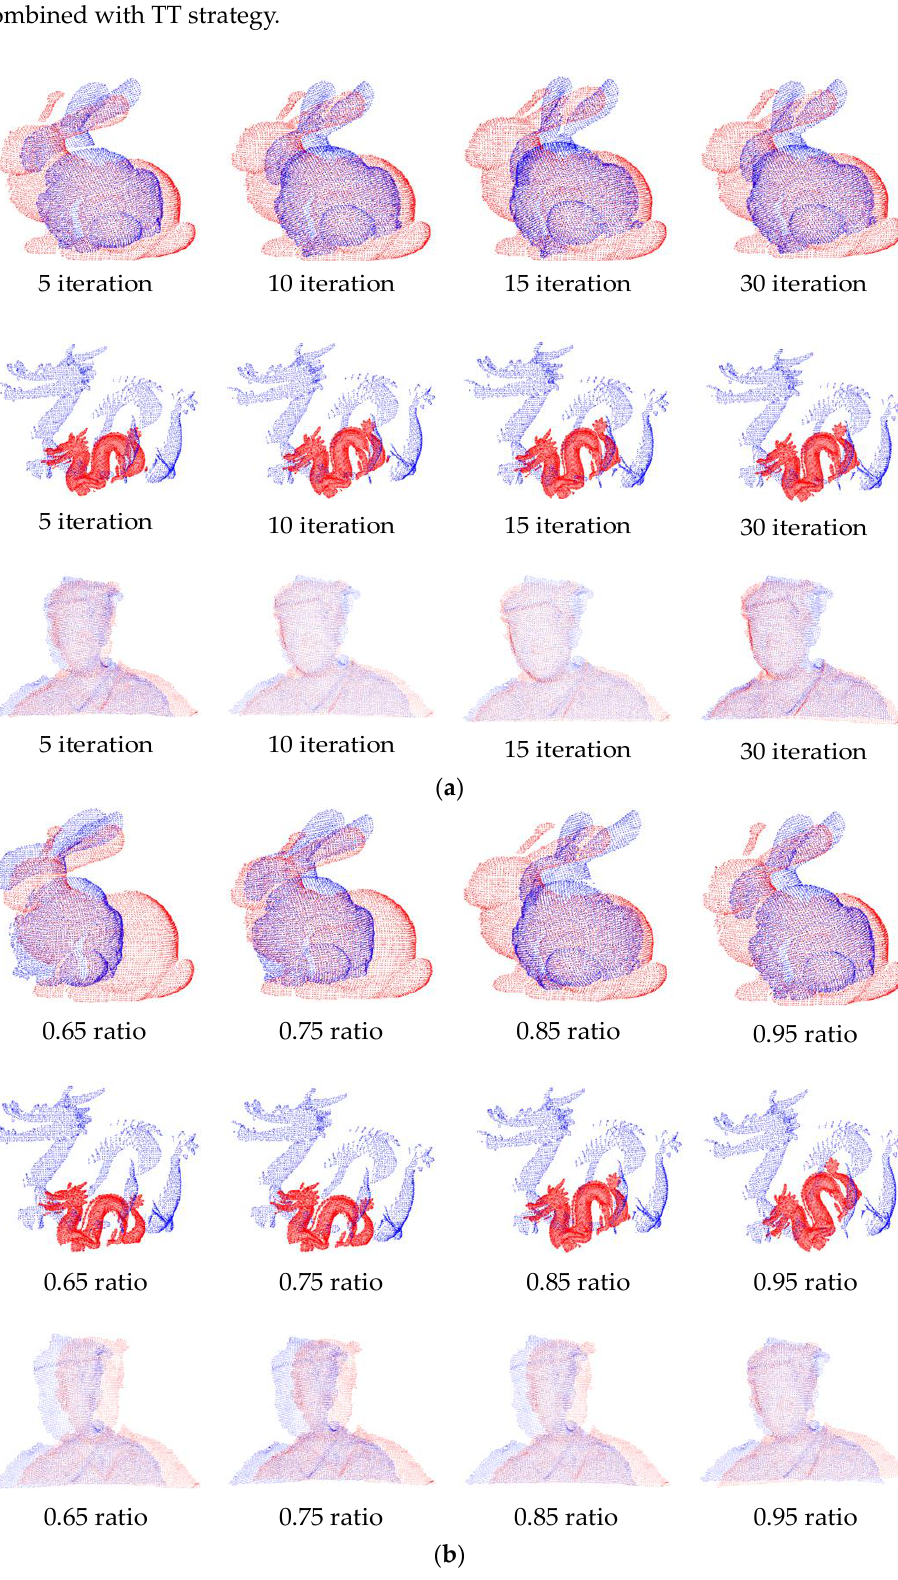
Figure 6. The registration results of two ICP algorithms with different parameter-setting conditions. ( a ) Three group data registration results of ICP with 5, 10, 15 and 30 iteration times. ( b ) Three group data registration results of TrICP with 0.65, 0.75, 0.85 and 0.95 overlap ratio.